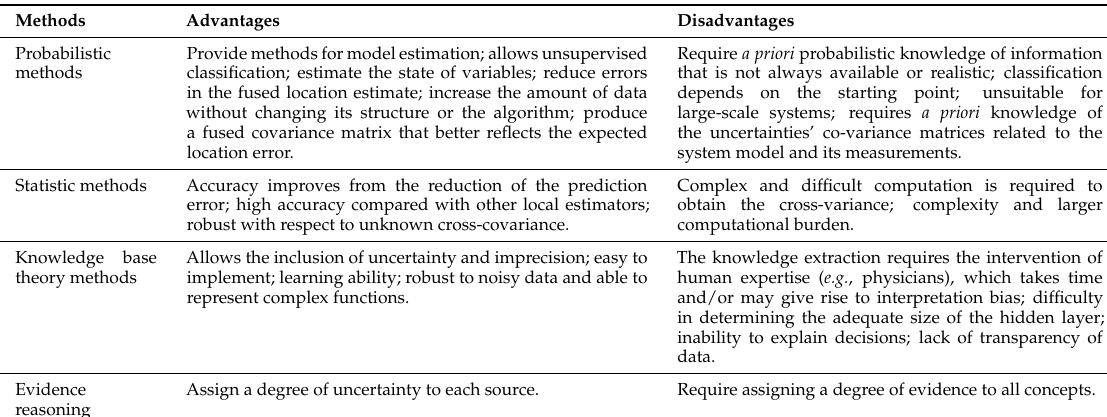
Table 5. Advantages and disadvantages of the sensor data fusion